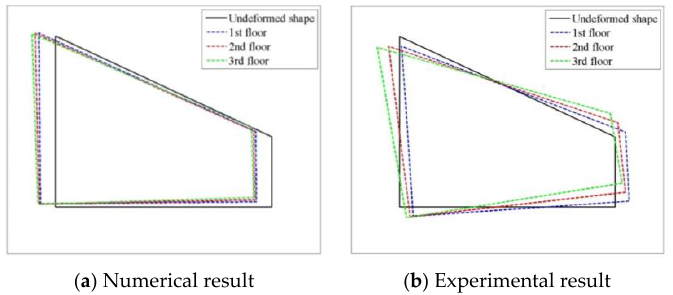
Figure 33. Displacement trace at sampling points during the Northridge main shock of Run 19.